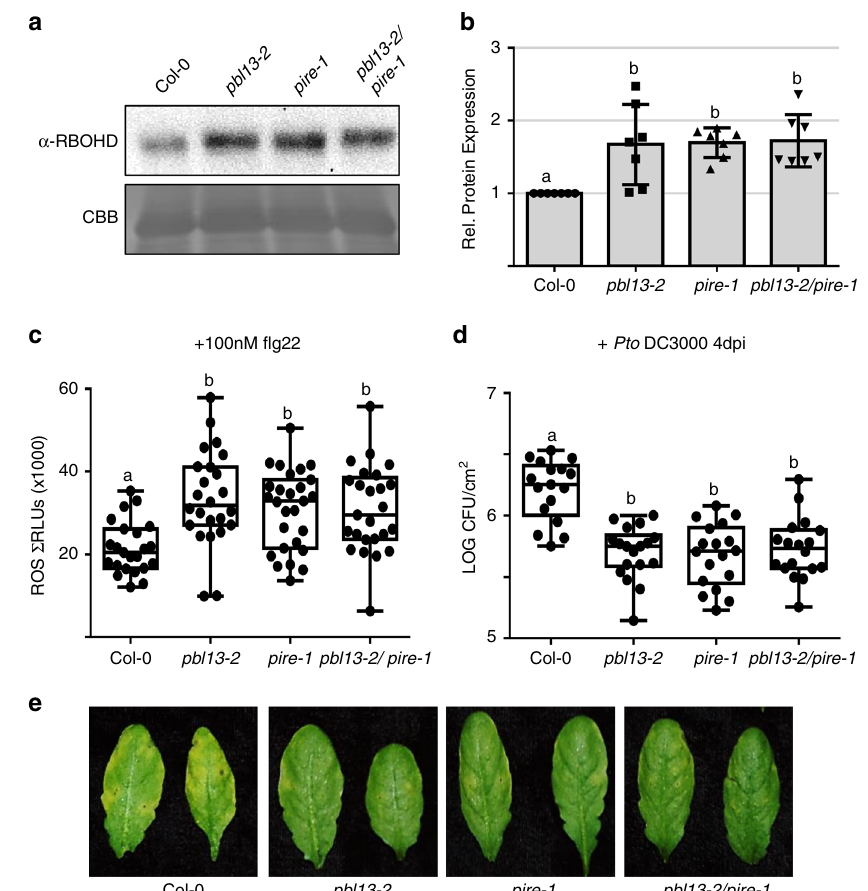
Fig. 7 PBL13 and PIRE negatively regulate defense responses. a The expression of RBOHD in pbl13, pire , and pbl13::pire knockout lines. RBOHD expression was detected by anti-RBOHD immunoblotting. b Quanti fi cation of RBOHD abundance in different genetic backgrounds. Expression was normalized to Col- 0. Statistical differences were determined by ANOVA with post-hoc Tukey HSD test, α = 0.05, n = 7 ± SD and letters indicate signi fi cant differences. c , d ROS burst c and bacterial titer d in Col-0, pbl13, pire , and pbl13::pire knockout lines. For the box-plot, whiskers indicate minimum and maximum values, line indicates the median, the box boundaries indicate the upper (25th percentile) and lower (75th percentile) quartiles, n > 23 for ROS burst and n = 18 for bacterial titers. Statistical differences were detected by ANOVA over all experiments with post-hoc Tukey HSD test, α = 0.01, and letters indicate signi fi cant differences. e Disease symptoms after Pto DC3000 infection on indicated genotypes 5 days post-inoculation